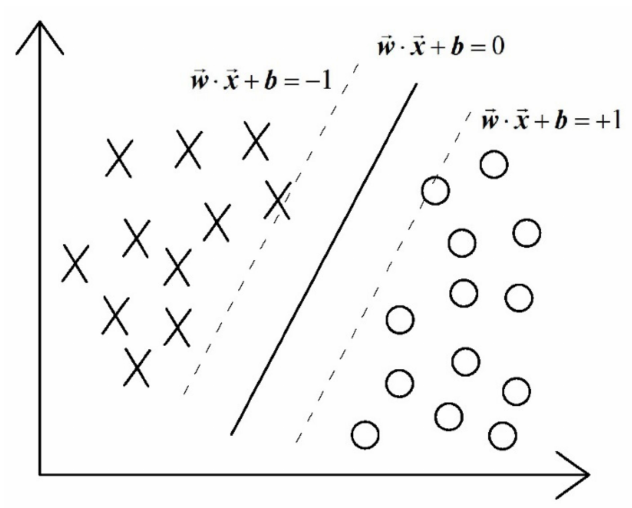
Figure 2. Schematic diagram of the classification of the output